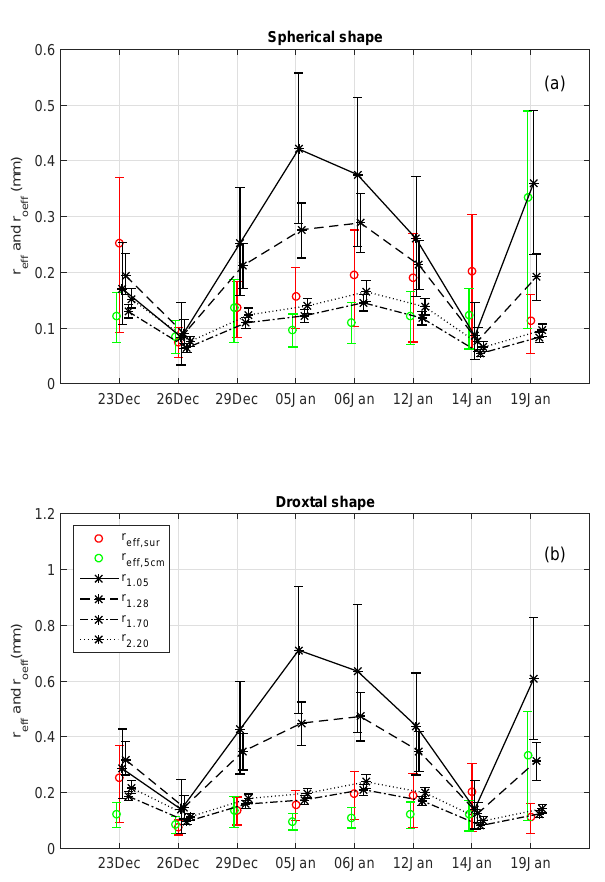
Figure 11. r eff obtained from the distributions of shortest skele- ton branches at the surface ( r eff,sur , red circles) and at 5cm depth ( r eff , 5cm , green circles), and r oeff derived with DISORT from spec- tral albedo observations at the wavebands centred on 1.05, 1.28, 1.70, and 2.20µm (stars with continuous, dashed, dashed-dotted, and dotted lines, respectively) during the eight case studies, for spherical (a) and droxtal (b) particle shapes. Error bars represent the uncertainties in the data and in the model calculations: for r eff,sur and r eff , 5cm , the uncertainty is calculated according to Eqs. (A3) and (A4) in Appendix A, while for r 1 . 05 , r 1 . 28 , r 1 . 70 , and r 2 . 20 the uncertainty results from the propagation of the errors in the particle metrics to the modelled albedo (E05 α, mod and E95 α, mod described in Appendix A3).